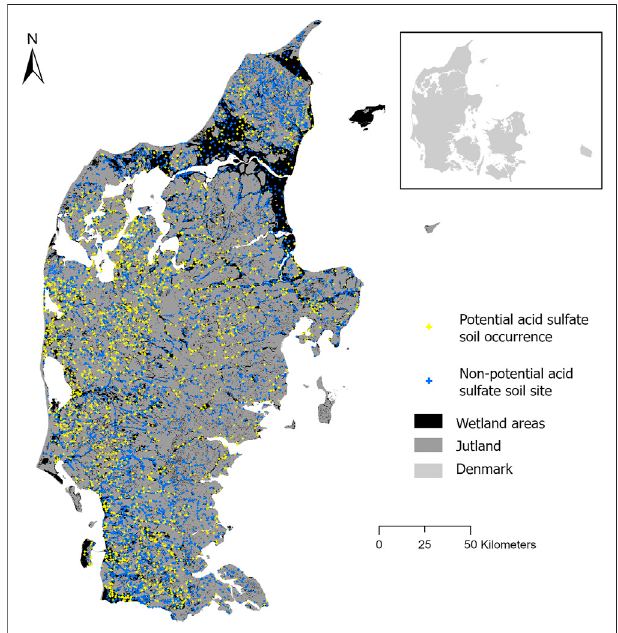
FIGURE 1 | Distribution of the soil observations in the study